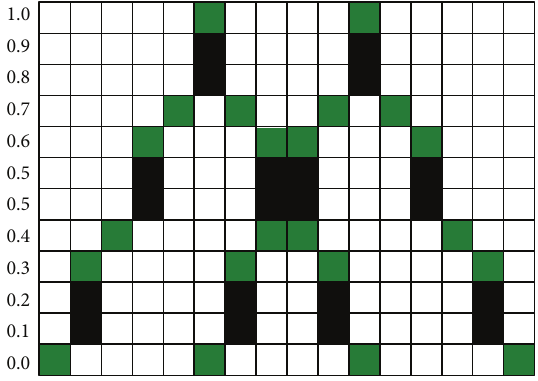
Figure 6: Template for basic function definition.